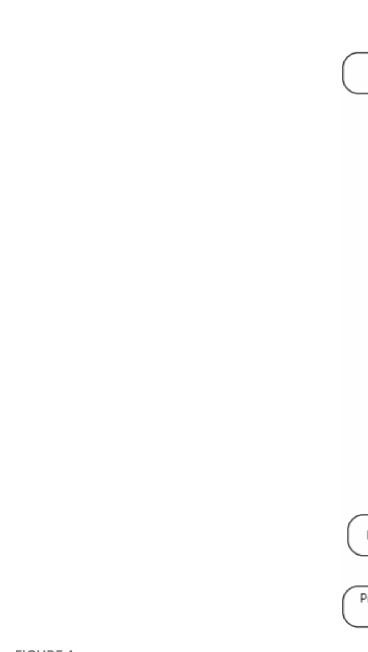
FIGURE 1 Flowchart for selection of bone metastases from lung